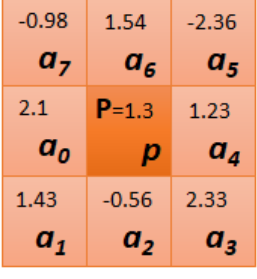
Figure 5. Eight neighbor locations for computation of LUPP value at